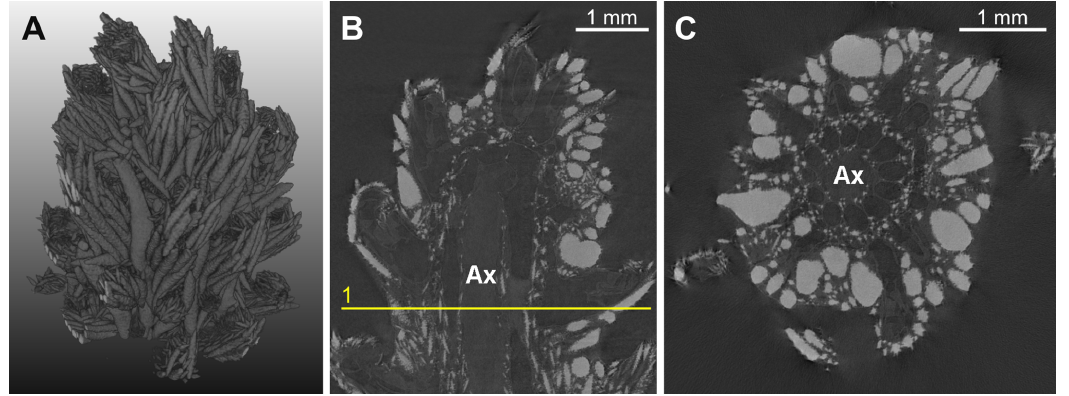
Figure 2. EX dataset. (A) volume rendering, (B) example of longitudinal slice, (C) axial slice corresponding to the initialization plane. The line superimposed onto the image represents the location of the initialization plane. The gorgonin axial skeleton was marked ‘‘Ax’’ and the calcite sclerites appear as bright spots of variable size and shape.